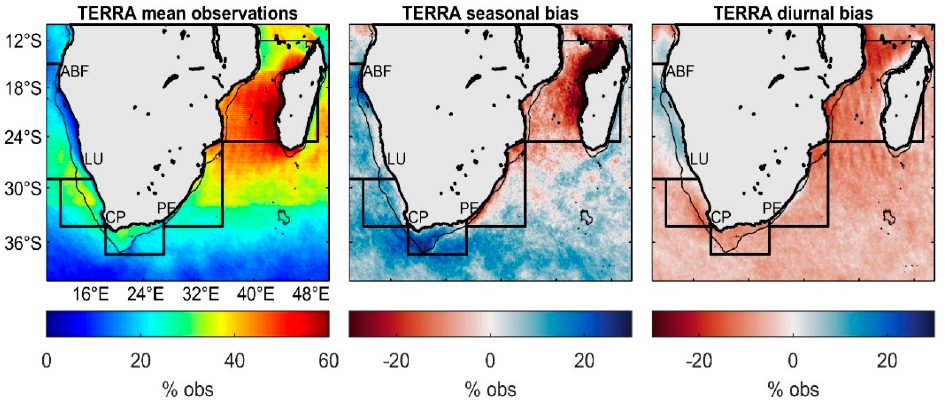
Figure 3. (Left panel) The mean percentage of valid observations for the L3 TERRA SST product during 1 January 2016–1 January 2019; (middle panel) the seasonal bias represented by the climatology of austral summer months (December, January and February) subtracted from the austral winter months (June, July and August) and (right panel) the diurnal bias represented by the day time observations subtracted from the night-time observations. The thick black boxes show the five defined sub-regions and thin black contour shows the 1000 m isobath. The labels ABF, LU, CP and PE represent the Angola–Benguela Front, Lüderitz, Cape Peninsula and Port Elizabeth regions, respectively.